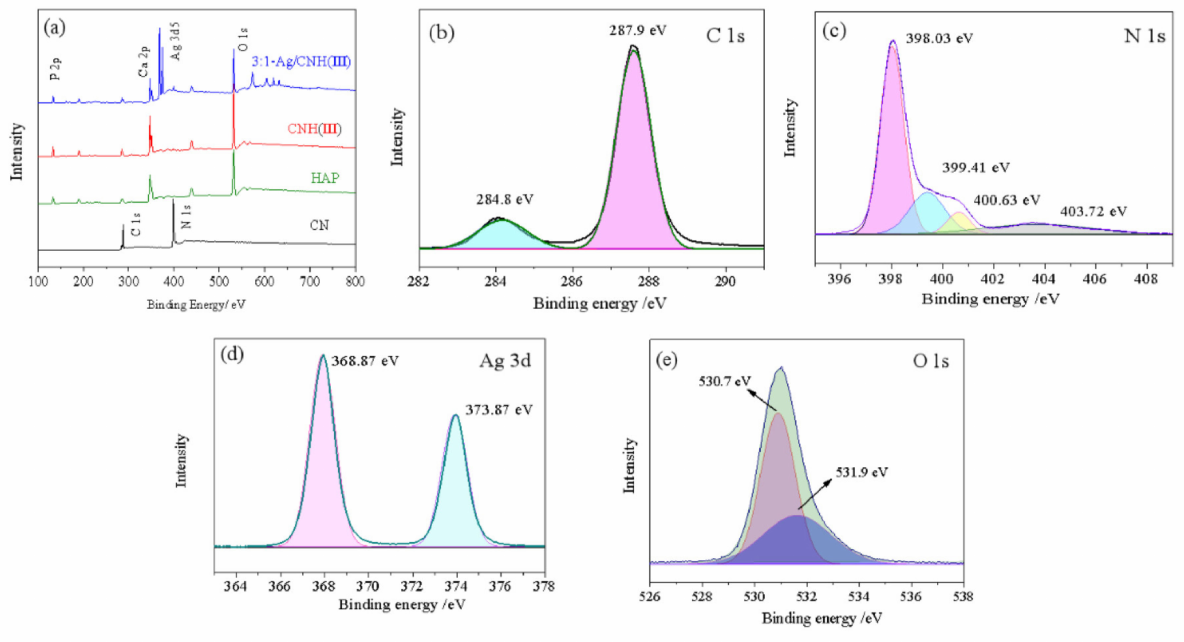
Figure 4. ( a ) XPS survey spectra of different samples; ( b ) C 1s peaks and ( c ) N 1s peaks over CN; ( d ) Ag 3d peaks and ( e ) O 1s peaks over Ag/CNH(III)